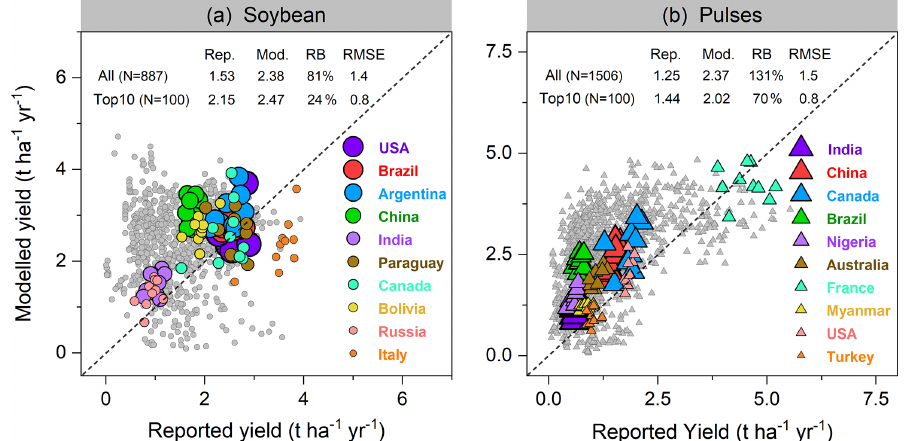
Figure 8. Per-country and per-year comparison of modeled yields of soybean (a) and pulses (b) against reported FAO statistics from 1996– 2005. Each filled circle in (a) represents 1 year and one country; thus, a country can have up to 10 circles over 1996–2005. In total, 887 and 1506 country–year yield data points were used for comparison in soybean and pulses, respectively. The top 10 producer countries (shown in color) were chosen based on their total production over the same period, and marker size from large to small indicates their total relative production in descending order. Rep. and Mod. respectively denote reported and modeled yield (tha − 1 yr − 1 ) averaged from 1996–2005. RB is relative bias (Eq. 16), represented in percent (%). The unit of RMSE is the same as yield (tha − 1 yr − 1